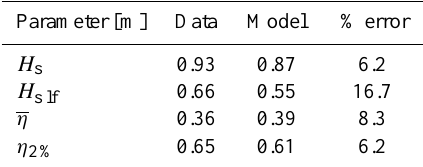
Table 4. Model–data comparison of significant wave height ( H s ), low-frequency significant wave height ( H s lf ), mean water level ( η ), and extreme water level ( η 2 % ) at LPM1. Wave conditions at LPM3 are H s = 3.8m and T p =